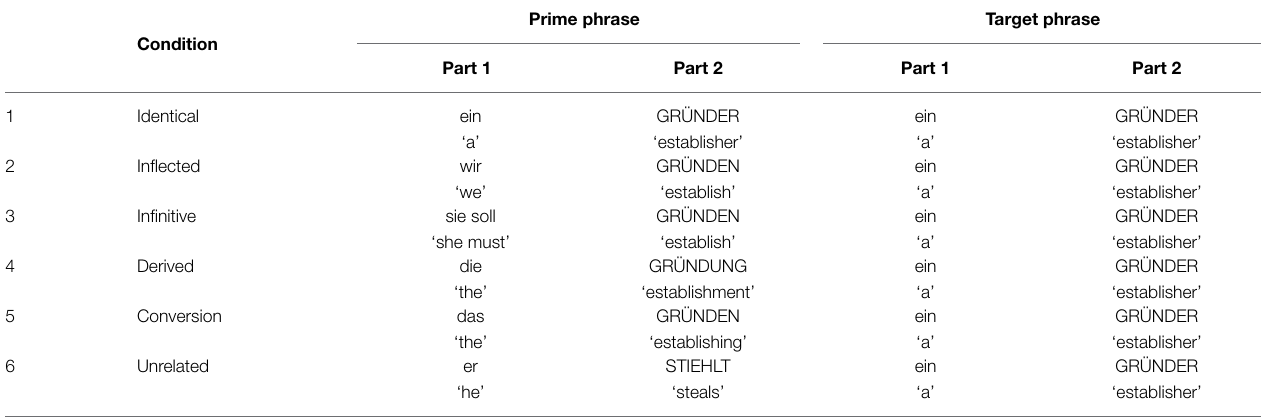
TABLE 7 | Experiment 4: experimental conditions and examples of prime and target